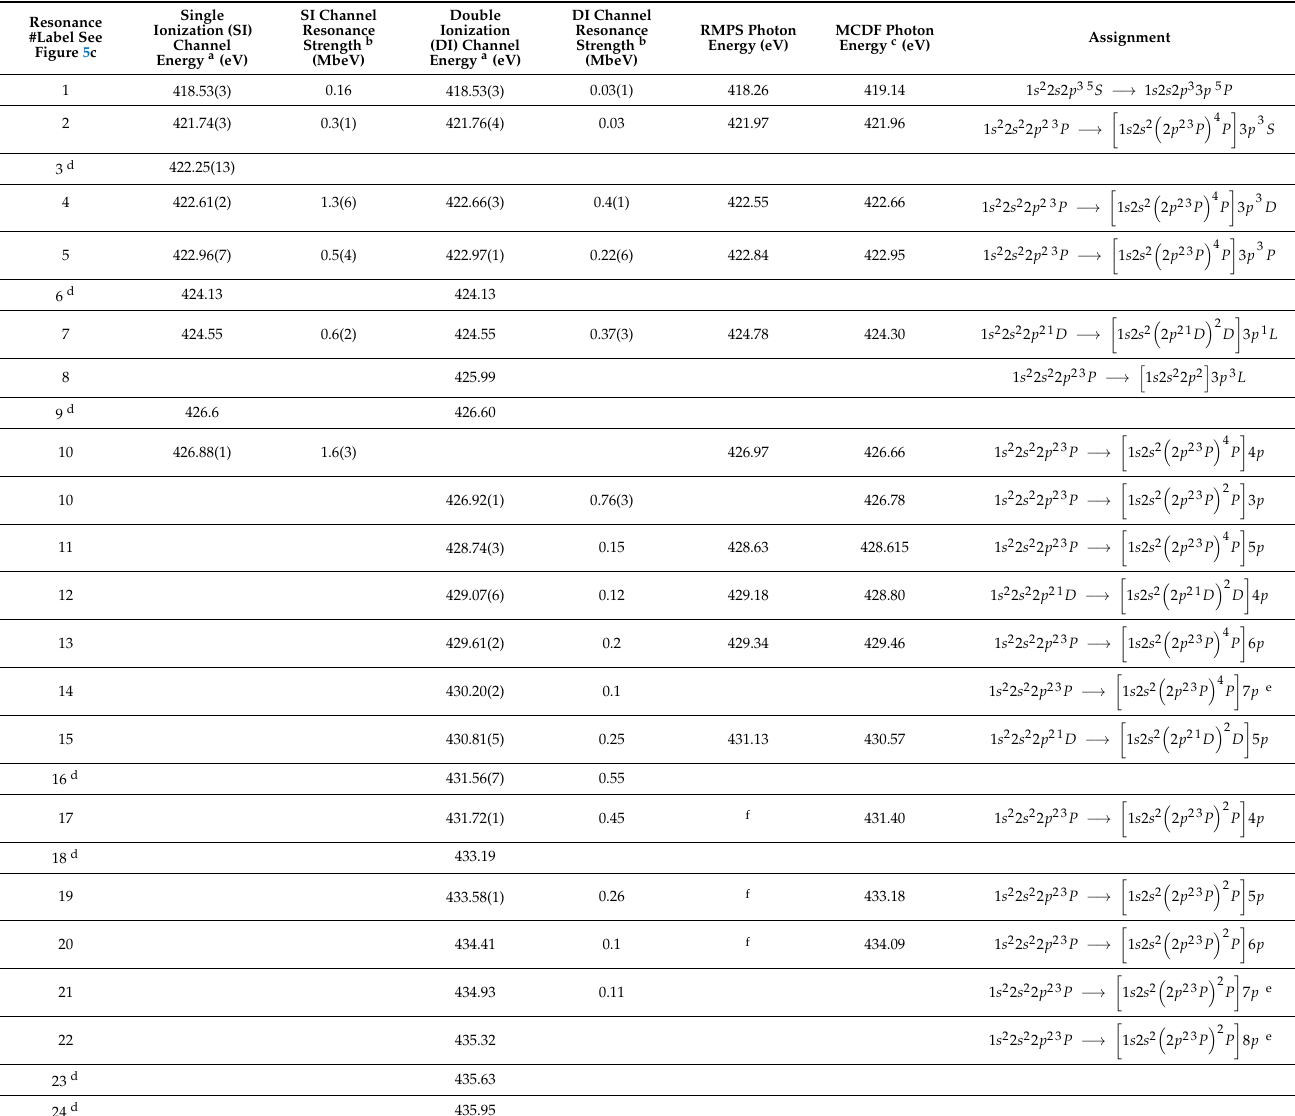
a Peak energy value obtained from a Voigt profile deconvolution of the experimental line shape. The number in brackets is the numerical uncertainty on the last digit. The overall energy uncertainly must also include the 60 meV energy calibration contribution (see text). b Obtained from a numerical integration of the measured line profile. The number in brackets is the numerical uncertainty on the last digit. This is at least 50% if no uncertainty value is quoted in brackets. No entry means that the error is too large for a strength value to be reliably quoted. c These energy values are shifted by +2.0 eV. d See text. e Assignment is based solely on Rydberg analysis of experimental energies. No theoretical RMPS or MCDF data are available. f RMPS energy not